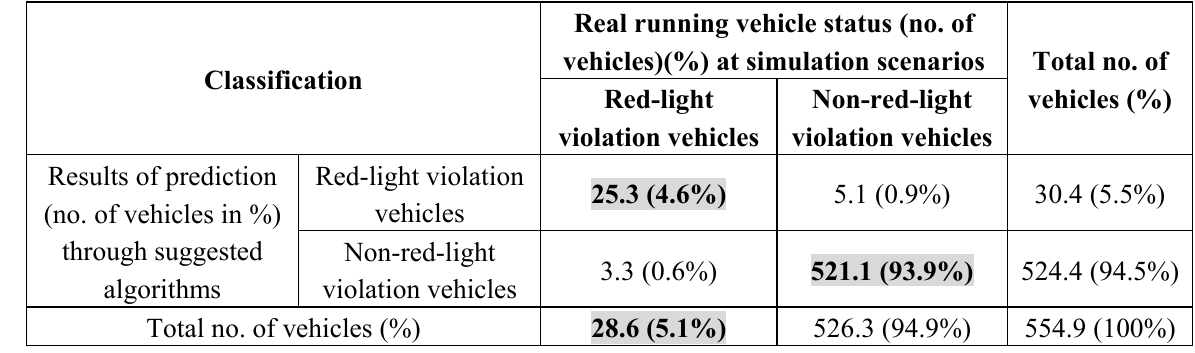
Table 2. Verification of the model